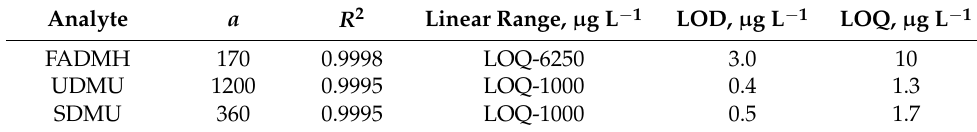
Table 3. The key specifications of the developed SFC-MS/MS method.